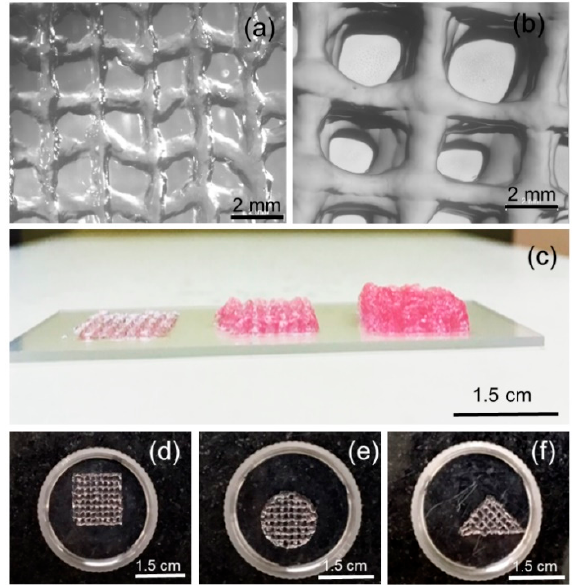
Figure 6. Printability aspects of ADA–Gel–PRP formulation. Stereo zoom microscope images suggested smooth and continuous filament formation in ( a ) single and ( b ) five-stack (or 10-layer) constructs. ( c ) Lateral view of single and multi-stacked constructs and ( d – f ) constructs in various shapes indicates the versatility of the formulation and bioprinting process.